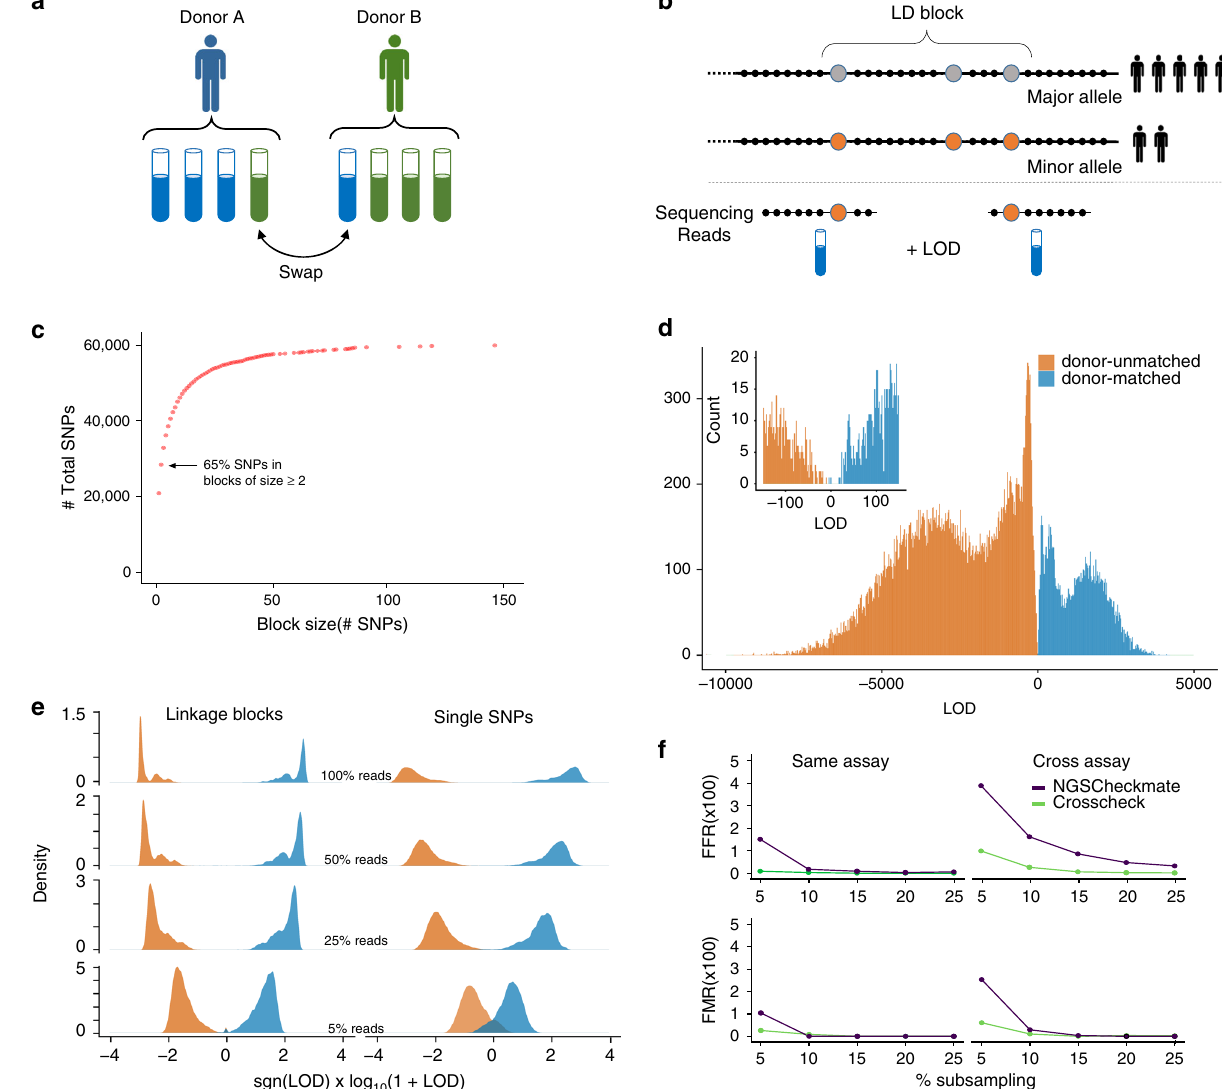
Fig. 1 Incorporating linkage information allows robust comparison of sequencing datasets. a Sample swaps and misannotations, where a sample is incorrectly attributed to the wrong donor, are a high stakes issue for large consortium projects and clinical science. b Our method compares reads from two datasets across a genome-wide set of linkage disequilibrium (LD) blocks (haplotype map). The single-nucleotide polymorphisms (SNPs) in each block are highly correlated with each other and have low correlation with SNPs in other blocks. Reads overlapping any of the SNPs in a given block inform the relatedness of the datasets, even when reads from the two datasets do not overlap one another. c Haplotype maps contain many large LD blocks. LD blocks are created using common, ancestry independent SNPs from 1000 Genomes. Most SNPs lie within blocks of size >2, which boosts the chances of reads to be informative. d Distribution of LOD (log-odds ratio) scores for 34,336 donor-mismatched (red) and 9767 donor-matched pairs (green) of public ChIP-, RNA-, and DNase-seq datasets from the ENCODE project. e LD-based method can correctly determine sample relatedness even at low sequencing coverage. Pairwise comparisons of reference dataset pairs at different subsampling percentages using two equally sized SNP panels — one panel contained only independent single SNPs, while the other contained only LD blocks. Donor-mismatched dataset pairs are colored red while donor-matched